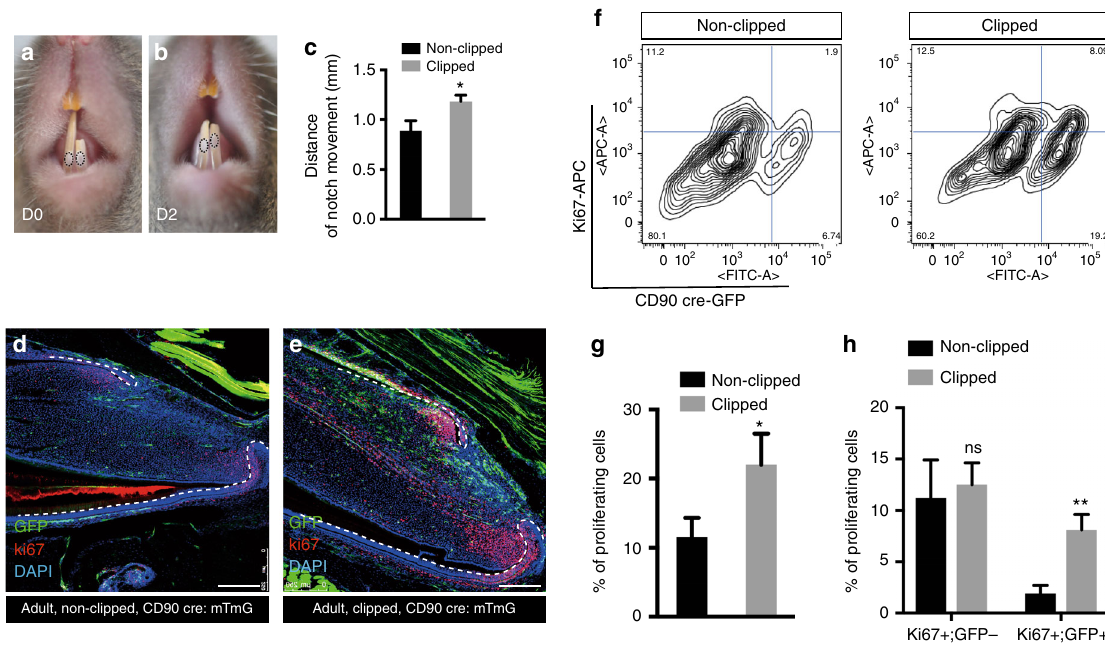
Fig. 4 Rapid expansion of CD90/Thy1 expressing MSCs contributes to re-establishment and homeostasis after adult incisor clipping. a – c 2 days after clipping (D2), notch movement on the unclipped incisor and clipped incisor was measured using a digital caliper, indicating faster growth of clipped incisor compared to the unclipped control ( n = 5, 8 – 10 weeks old adult mice). d , e Immuno- fl uorescent staining of the cell proliferation marker, Ki67 on CD90/ Thy1 cre; mTmG mice with clipped incisors showing higher proliferation and increased contribution to the pulp cells and odontoblasts from CD90/Thy1- derived cells than in non-clipped incisors. f – h FACS analysis and quanti fi cation shows signi fi cantly increased numbers of proliferating cells in clipped incisors with almost all the increase in proliferating cells being accounted for by CD90/Thy1 + cells (Ki67 + ;GFP+), while the Ki67+;GFP − cell population remains constant. Bar is 250 µ m. * P < 0.05 and ** P < 0.01 by Student ’ s t -test. Data presented as mean ±